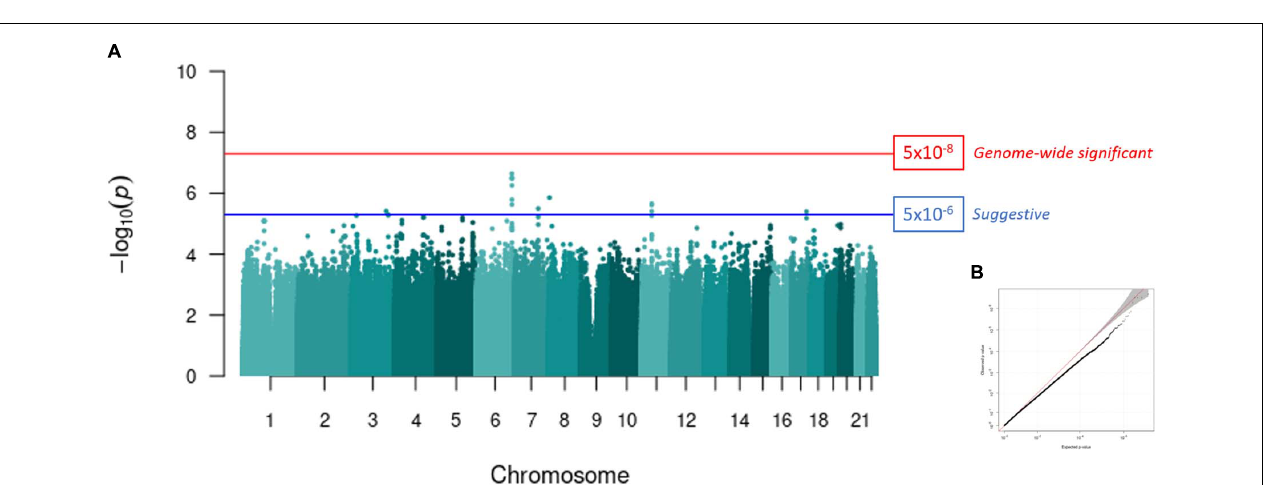
FIGURE 1 | Principal component analysis with 1000 Genomes Project Phase 3 data. Shared Roots (A–C) Wave 1 and (D–F) Wave 2 participants and 1000 Genomes Phase 3 samples plotted together based on principal components (PC1–3) from overlapping SNP data. Shared Roots participants (gray) cluster separately from the other population groups. AFR, African ancestry; AMR, Admixed American ancestry; EAS, East Asian ancestry; EUR, European ancestry; SAS, South Asian ancestry; and SAC, South African Colored (Shared Roots).